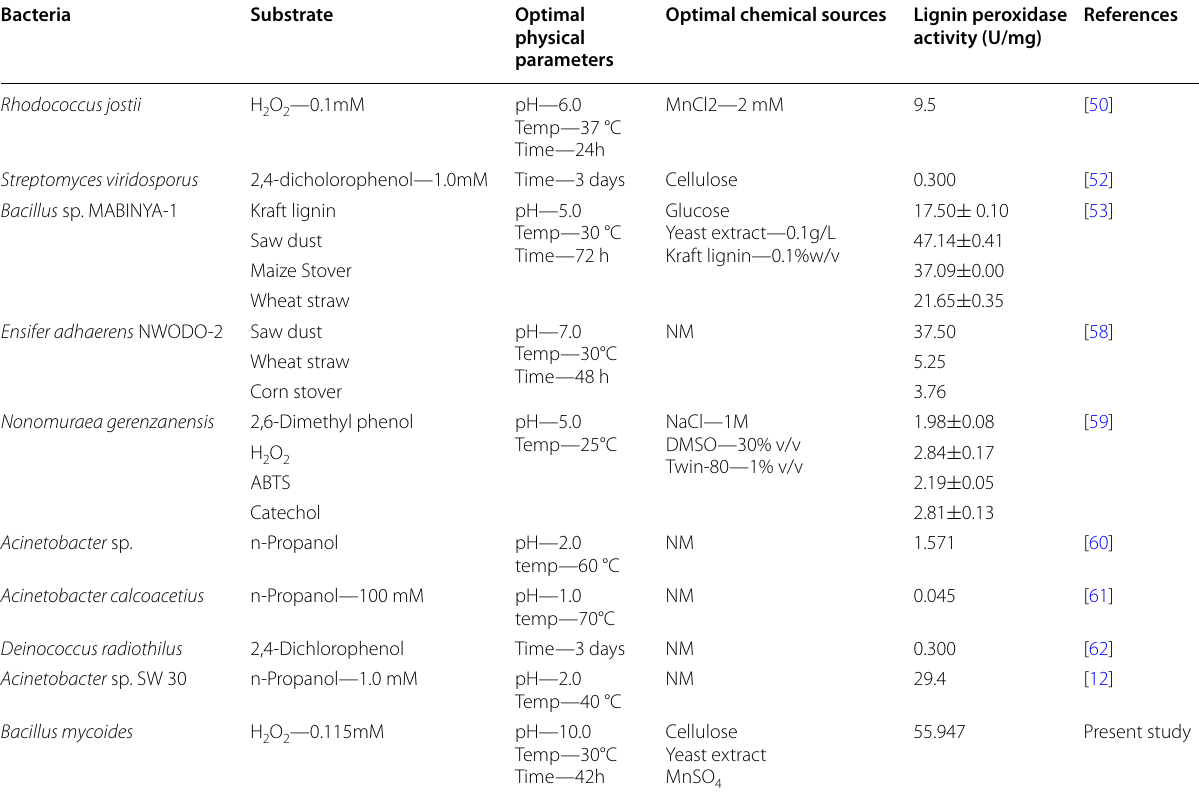
Table 4 Comparison of lignin peroxidase activity in different bacterial